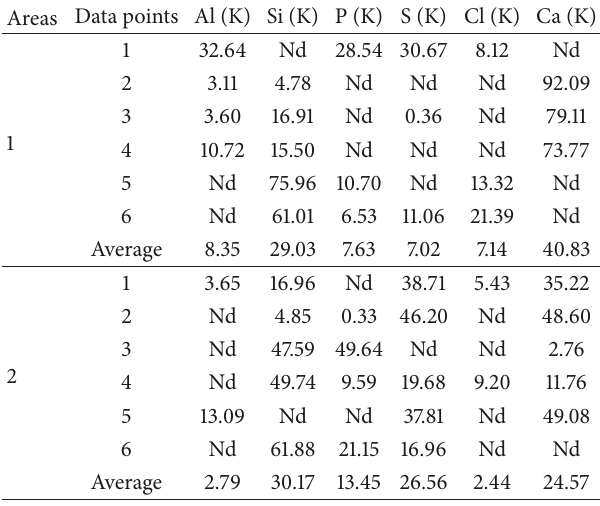
Table 3: TEM-EDS analysis of elements and their percentages of weight (wt.%) in EF PE